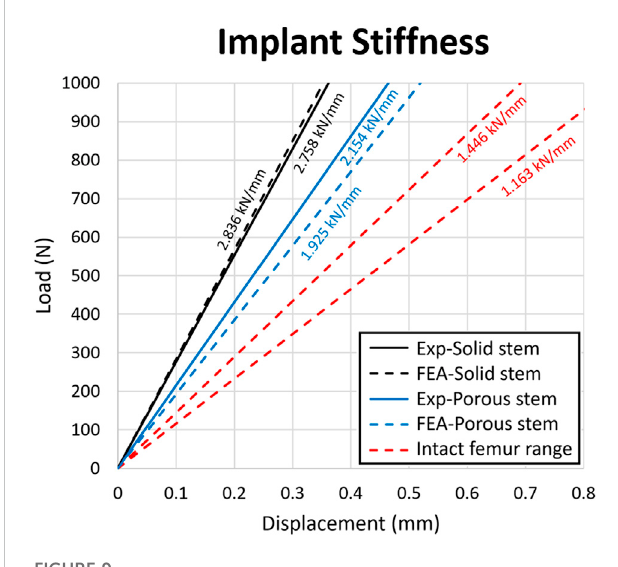
FIGURE 9 Load-displacement data for the solid stem, porous stem and intact femur. The stiffness value of each con fi guration was presented above the respective slopes on the diagram. Strain value corresponding to the 0.8 mm displacement was